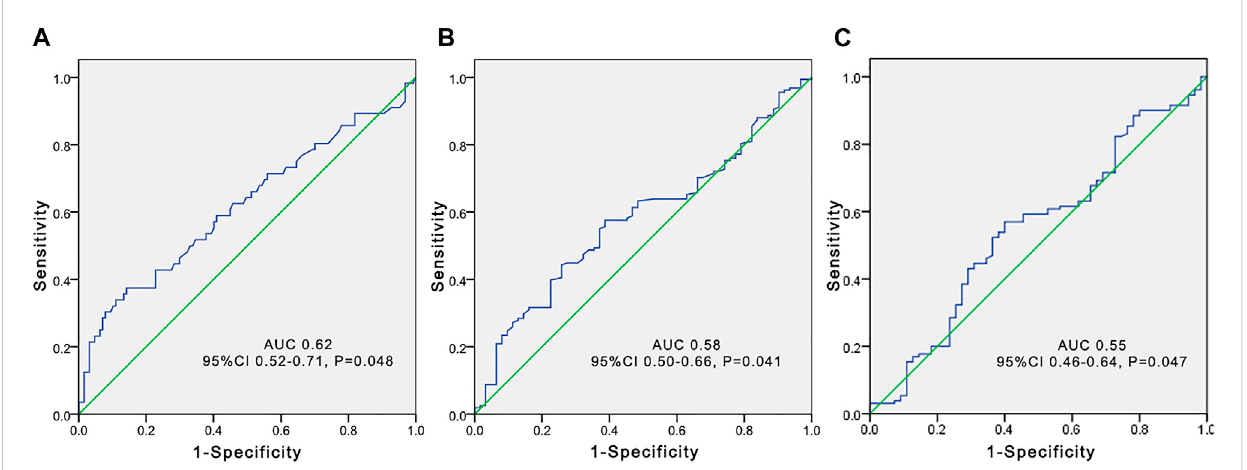
FIGURE 4 Receiver operating characteristic (ROC) curve to predict voriconazole trough concentrations greater than 5 μ g/ml according to the total bile acid level (A) , platelet count (B) , and estimated glomerular fi ltration rate (C) in elderly